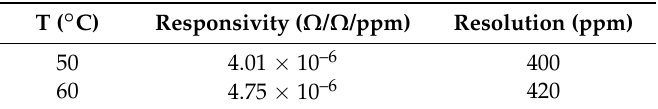
Table 1. Responsivity and resolution of the CO 2 sensor estimated for the two operating temperatures of 50 °C and 60 °C.